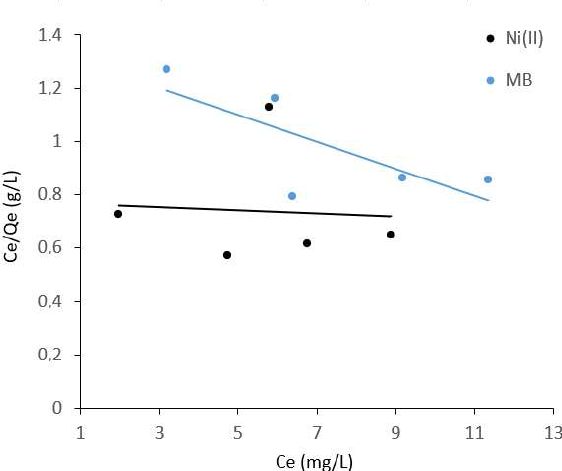
Fig.8. Langmuir adsorption isotherm for removal of Ni(II) ions and MB onto natural clay